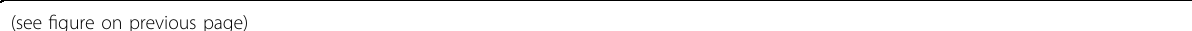
Fig. 1 Increased RGMa expression is induced by MPTP injection. A Schematic representation of the MPTP injection and sample preparation timeline. B Immuno fl uorescent staining for TH in the SNc of mice injected with saline or MPTP. Scale bar, 200 μ m. C A representative image after the collection of the SN using laser microdissection. Scale bar, 200 μ m. D , E Relative mRNA expression levels of RGMa and Neogenin ( D ), and co-receptors for RGMa ( E ) in the SN. The RGMa mRNA level is increased in the MPTP-treated group compared with the saline-injected group. n = 5. * P < 0.05, Welch ’ s t test. F Coimmunostaining of RGMa (red) with the dopaminergic neuronal marker TH (green) in the SN of an MPTP-treated mouse at day 21 after the last MPTP injection. Scale bar, 150 μ